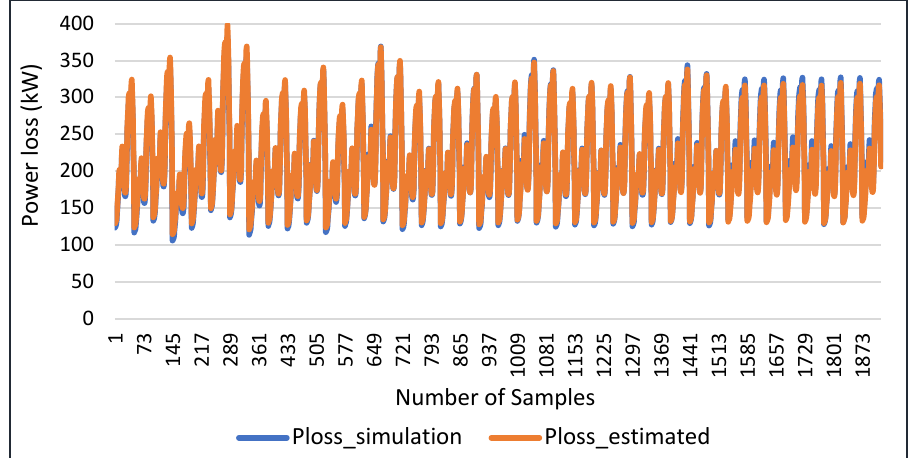
Figure 8. Active power loss obtained for case 3 for function 1.